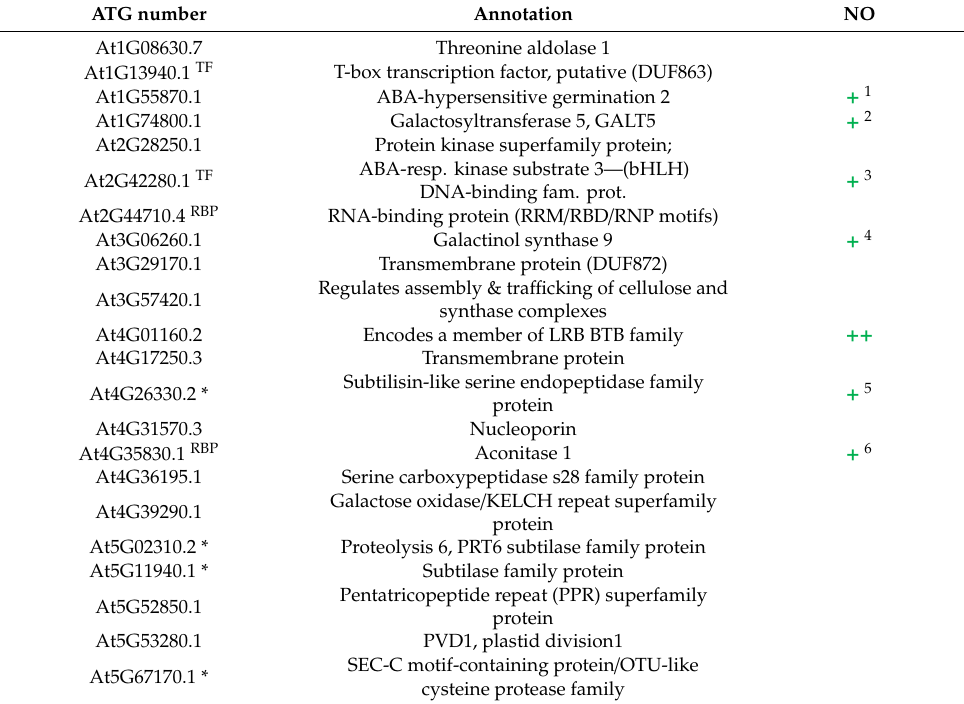
Table 1. Arabidopsis thaliana proteins that contain the following modified Heme Nitric Oxide / Oxygen (H-NOX) motif: